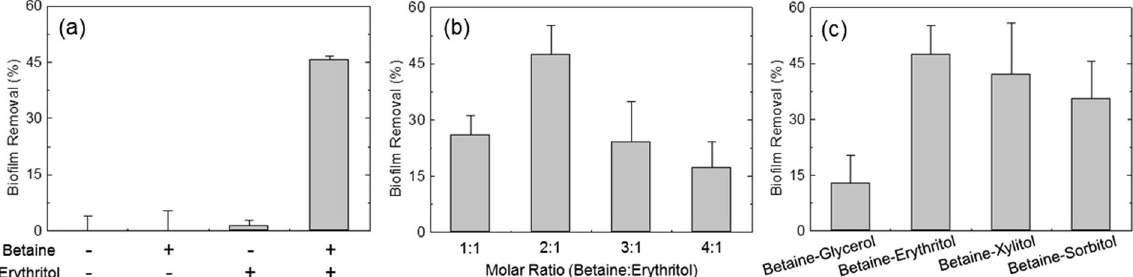
Figure 1. ( a ) Biofilm-removal efficiency of a mixture consisting of betaine and erythritol. S. mutans biofilms were exposed to 5.6 mM betaine, 2.8 mM erythritol and a mixture thereof, respectively. ( b ) Effect of the molar ratio between betaine and erythritol on biofilm removal. Weight fractions of the mixtures of betaine and erythritol were 0.1% in all samples. ( c ) Effect of hydrogen bond donor (HBD) combined with betaine on biofilm-removal efficiency. Betaine was combined with glycerol, erythritol, xylitol, and sorbitol at molar ratios of 3:2, 2:1, 5:2, and 3:1, respectively. In all figures, each value and error bar indicates mean and standard deviation (SD), respectively ( n =